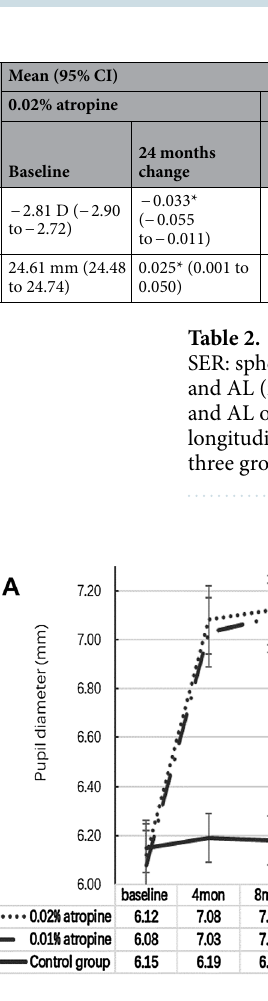
Figure 3. Measurement of pupil diameter and accommodation amplitude over time.